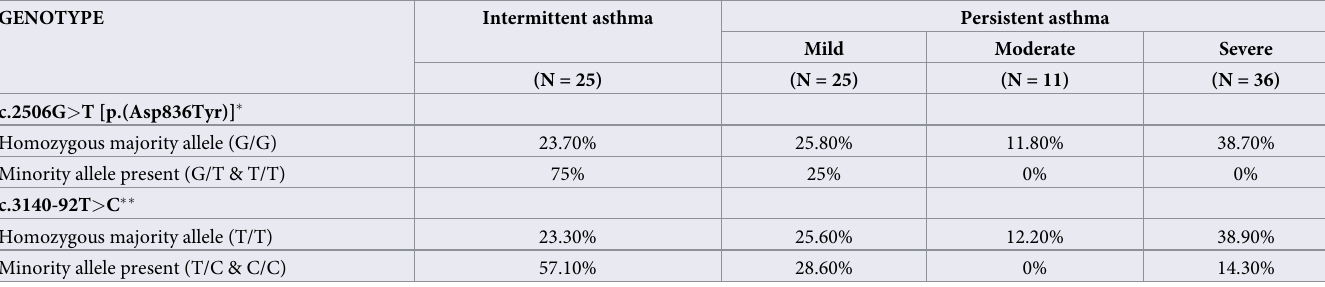
Table 3. Polymorphisms associated with the CFTR gene according to asthma severity.